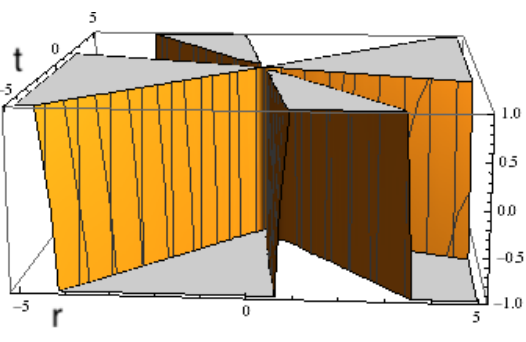
Figure 2. Stability region of z = ex 2 ( r , t )